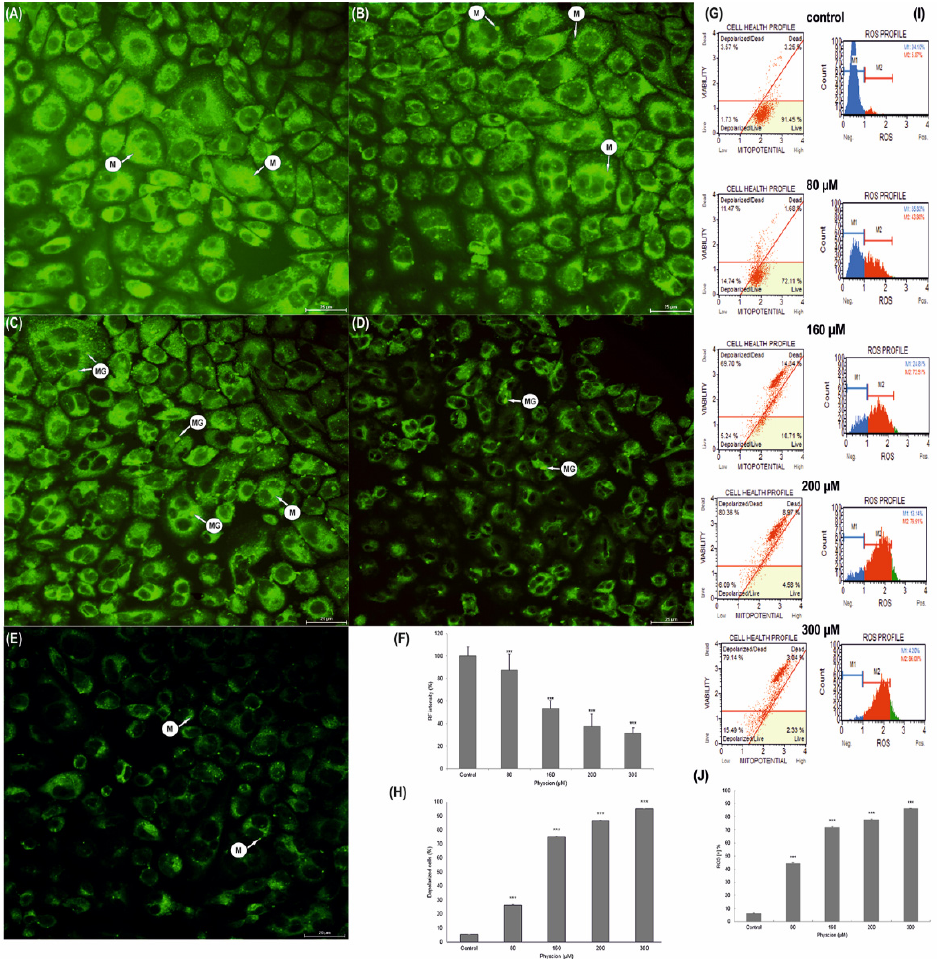
Figure 4. Morphological and biochemical changes in mitochondria of Hela cells after physcion treatment. Mitochondrial membrane potential change analysis based on rhodamine 123 staining. Representative photos of control cells with high mitochondrial membrane potential ( A ) and cells incubated for 48 h with physcion at concentrations of 80 μ M ( B ), 160 μ M ( C ), 200 μ M ( D ) and 300 μ M ( E ). Relative fluorescence intensity expressed as a percentage of the control group ( F ). Data correspond to mean values ± S.E. M—mitochondria, MG—megamitochondria. Magnification, ×4000. Changes in mitochondrial membrane potential dependent on physcion concentration ( G ). Percentage of cells with depolarization of the mitochondrial membrane ( H ). Each sample was analyzed in triplicate. The differences were statistically confirmed at: *** p < 0.001. Generation of reactive oxygen species (ROS) by physcion at concentrations of 80 μ M, 160 μ M, 200 μ M and 300 μ M ( I ). Percentage of ROS (+) cells induced with physcion ( J ). The degree of ROS production in cells was determined in comparison with the control. Each sample was analyzed in triplicate. The differences were statistically confirmed at: *** p < 0.001.